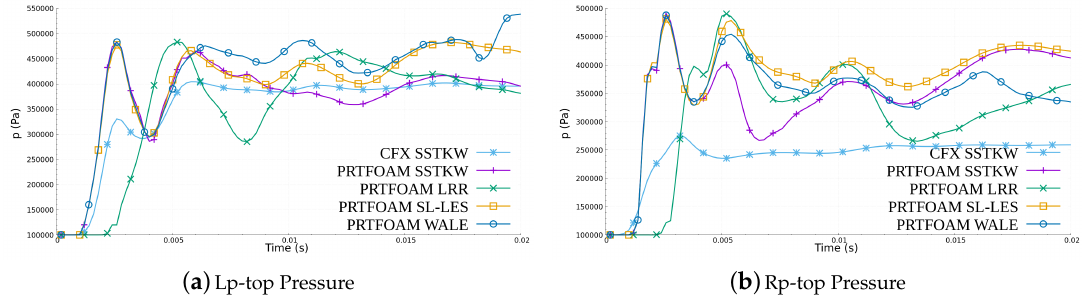
Figure 16. Pressure–time curves of the simulation results of different models at the ( a ) Lp-top and ( b ) Rp-top sampling points. The simulated dumping process of LRR model is significantly slower than that of other models. There is a large gap between the data of the left and right sampling point simulated by commercial software